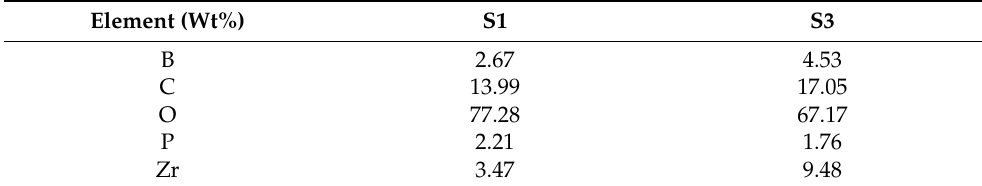
Table 2. EDX results for the hybrid compounds S1 and S3.